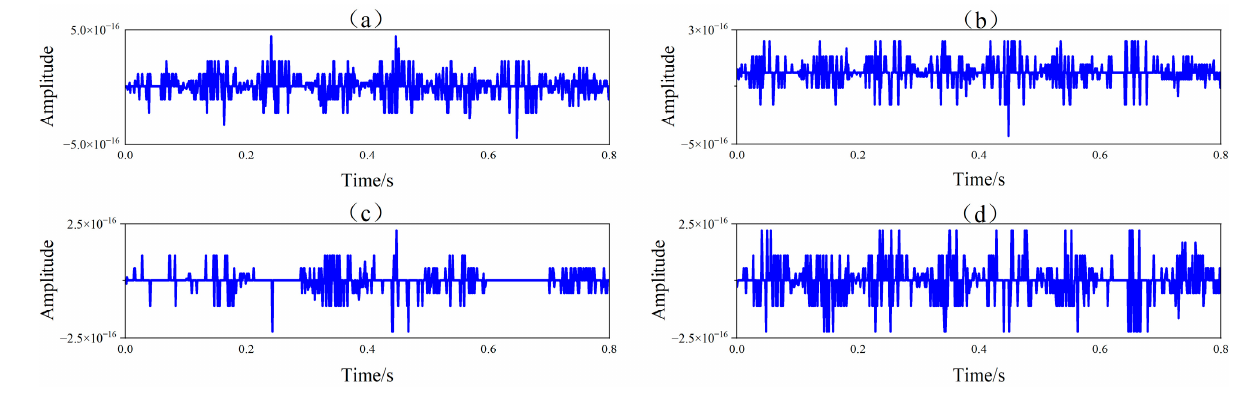
Figure 7. Residual noise from: ( a ) CEEMDAN, ( b ) ICEEMDAN, ( c ) RLMD, ( d ) CCERLMDAN.